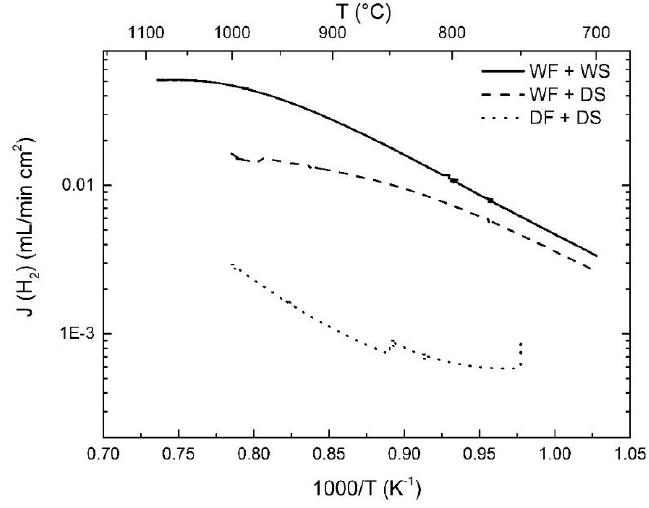
Figure 2. The apparent hydrogen flux as a function of temperature measured upon cooling from high to low temperatures under various feed and sweep gases. The sweep Ar flow is 25 mL/min.